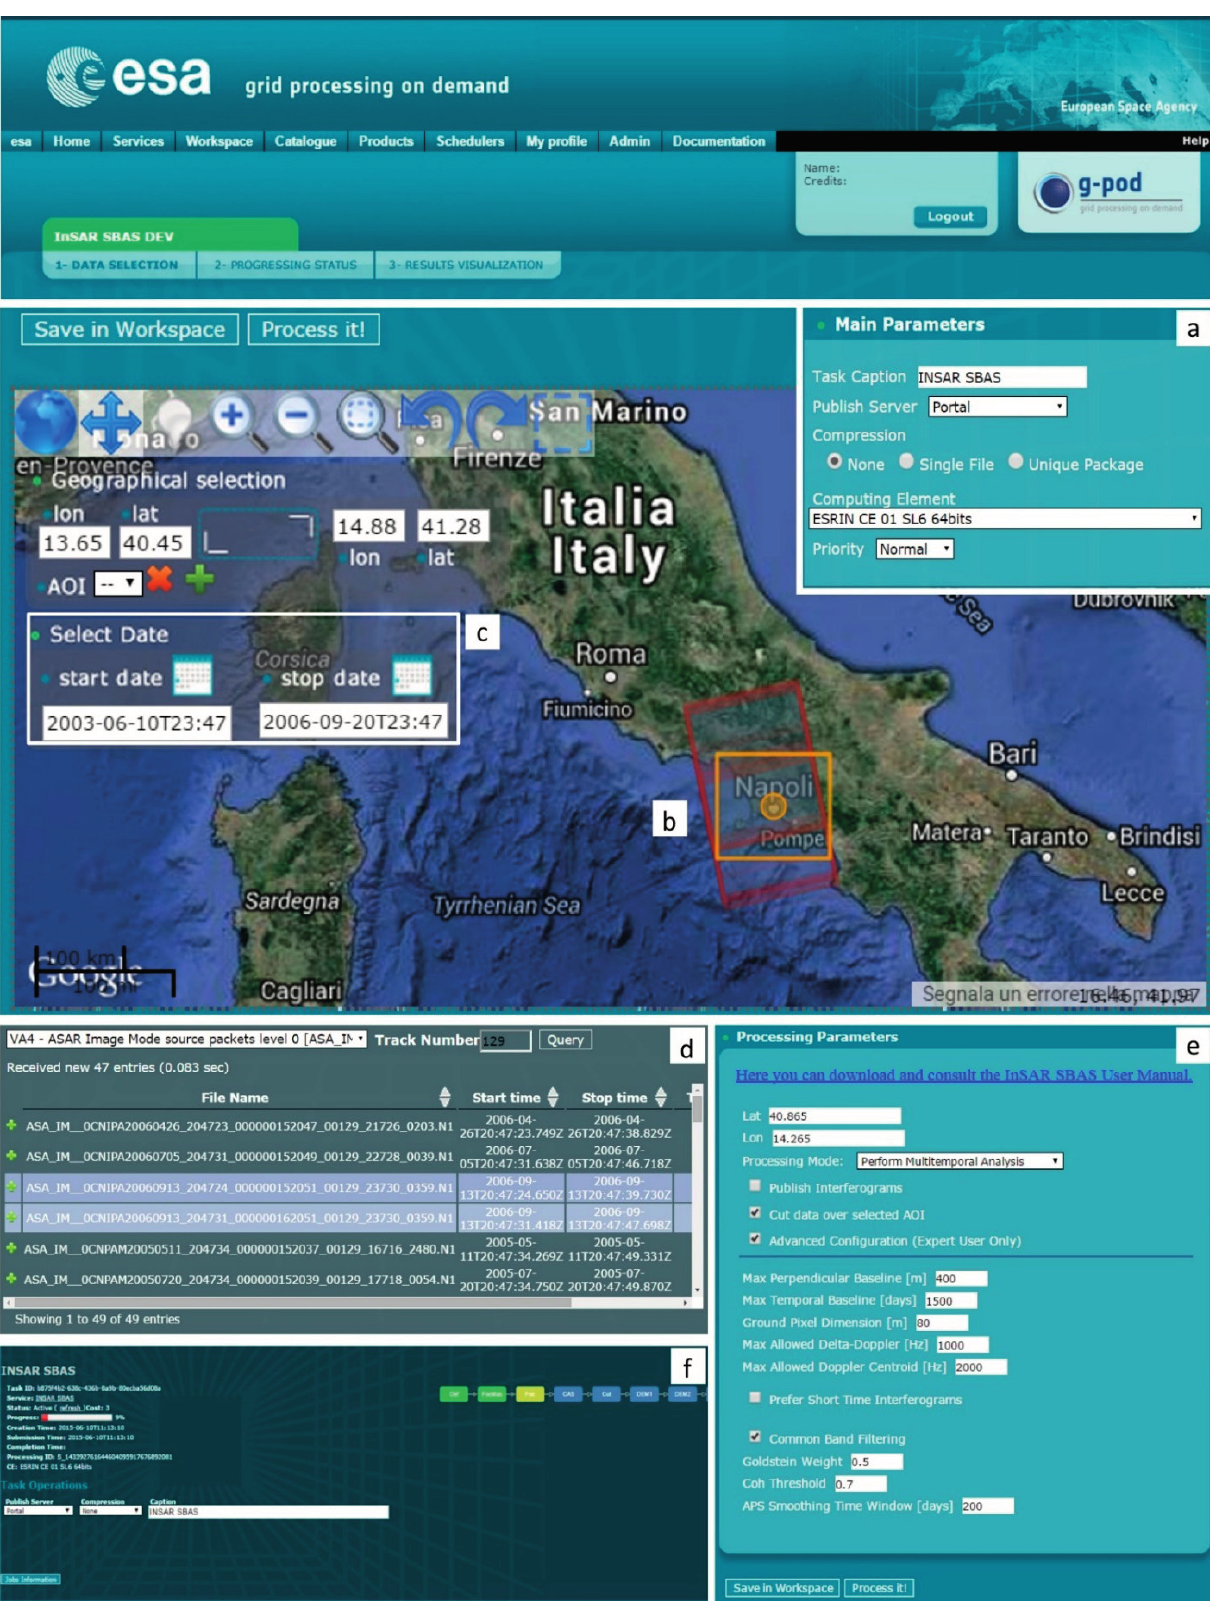
Figure 2. P-SBAS tool web portal. ( a ) Main processing Parameters window, ( b ) geographic map client for the AoI and data selection, ( c ) investigated time interval selection, ( d ) SAR data catalogue query, ( e ) interferometric processing parameters window, and ( f ) job status